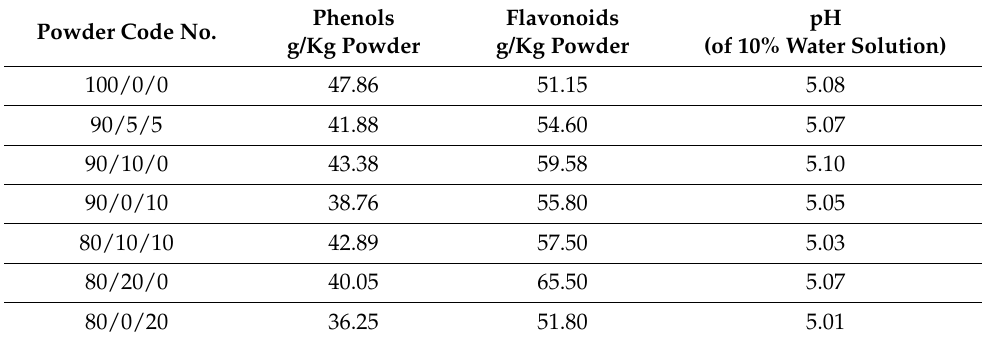
Table 1. Concentration of total phenols, flavonoids, and pH values of the selected antimicrobial powders.